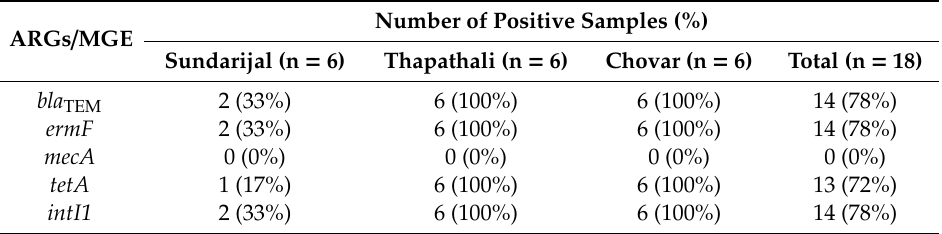
Table 1. Positive ratios of antibiotic resistance genes (ARGs) and intI1 in river water samples. Number of Positive Samples ARGs / MGE